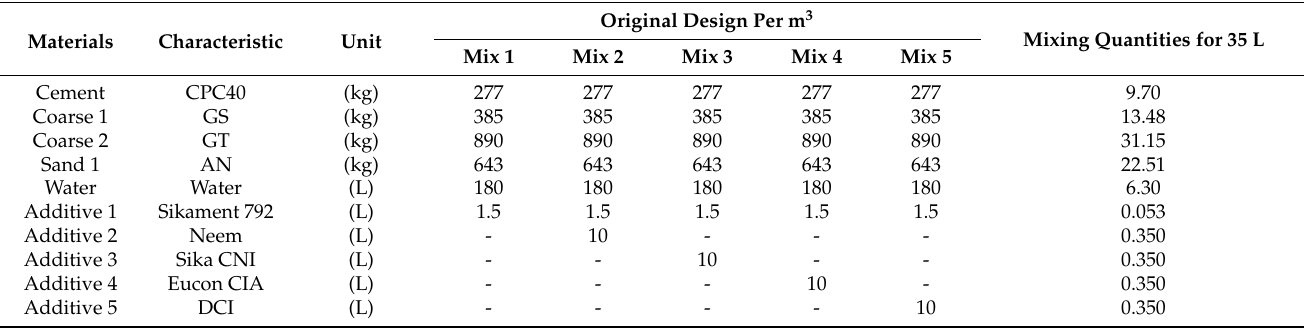
Table 6. Admixture